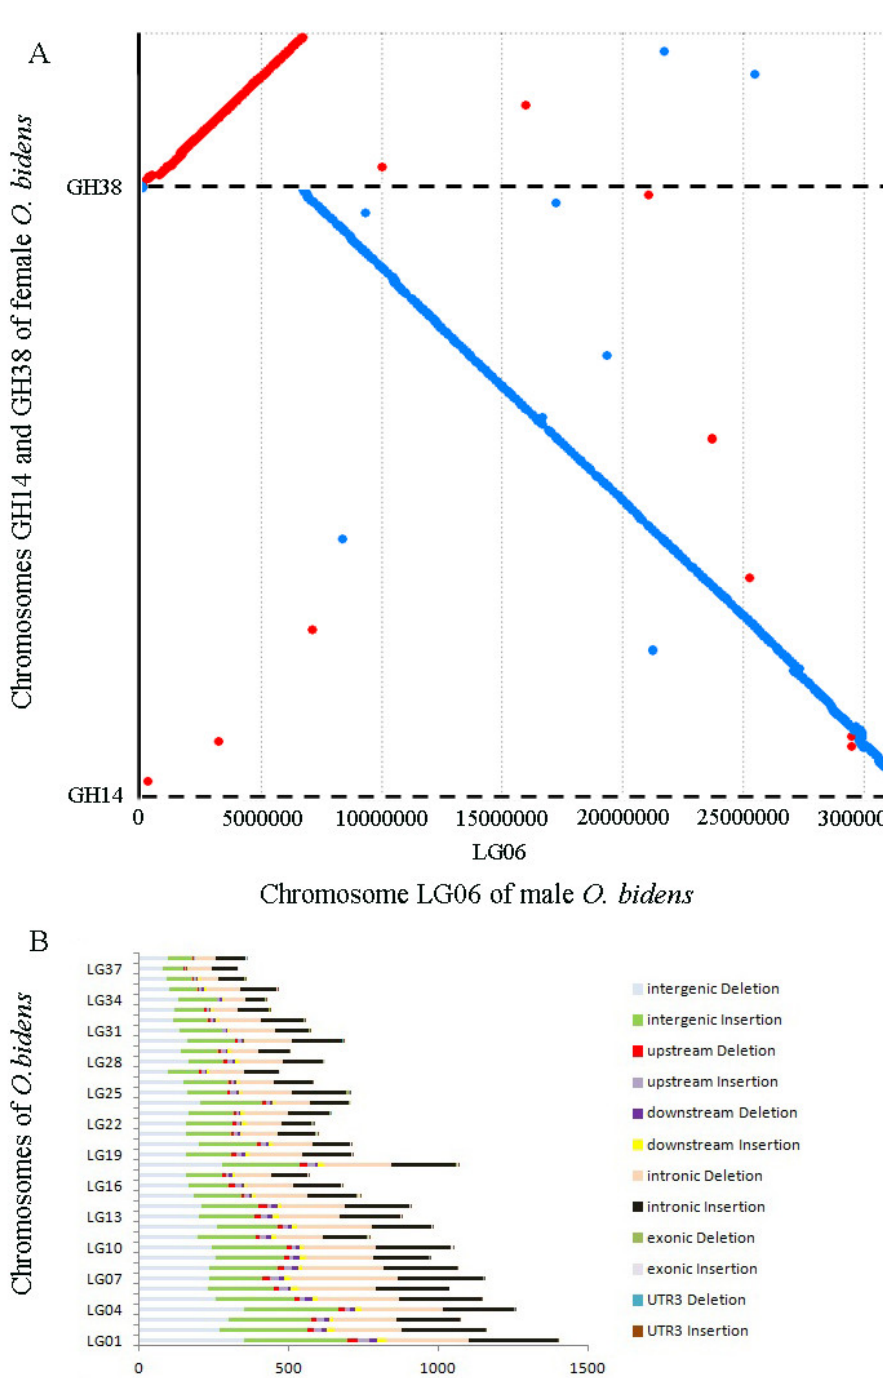
Figure 7. Detail chromosome comparisons between LG06, GH14, and GH38, and structure variation between female and male O. bidens genomes. ( A ) The chromosome LG06 of male O. bidens genome showed significant synteny with GH14 and GH38 of female O. bidens genome. ( B ) Statistics of the structural variations in various regions of the male genome by alignment with female O. bidens ge- nome.